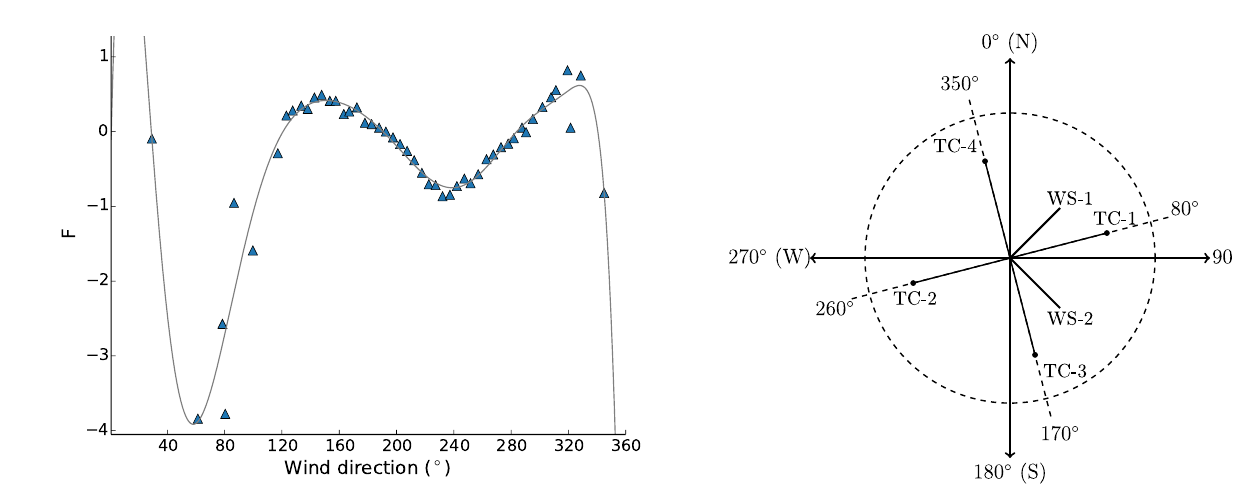
Figure 9. Calibration function F 4 for velocity class 4. Table 2. VL1’s look-up table of the developed wind reconstruction algorithm.